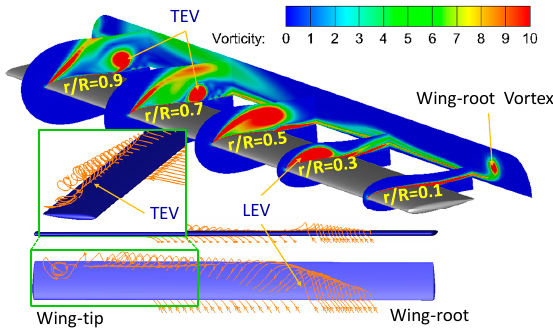
Figure 11. Vorticity of dynamic-stall vortex at different wing sections.